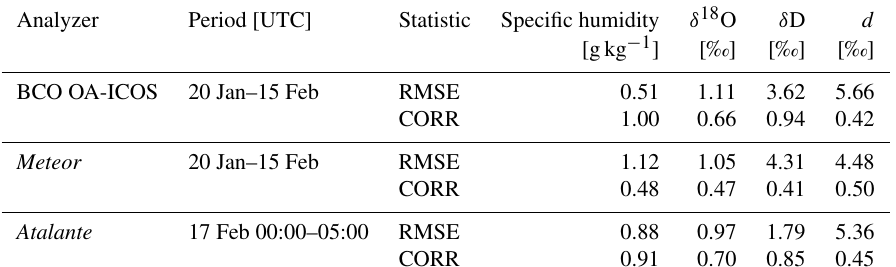
Table 2. Root mean square error (RMSE) and Pearson correlation coefficients (CORR) for comparisons between the BCO CRDS time series and the time series of three other analyzers, smoothed with 1h moving averages. Meteor data were shifted by 9h and Atalante data were shifted by 10min to account for the geographic distance between measurement sites.